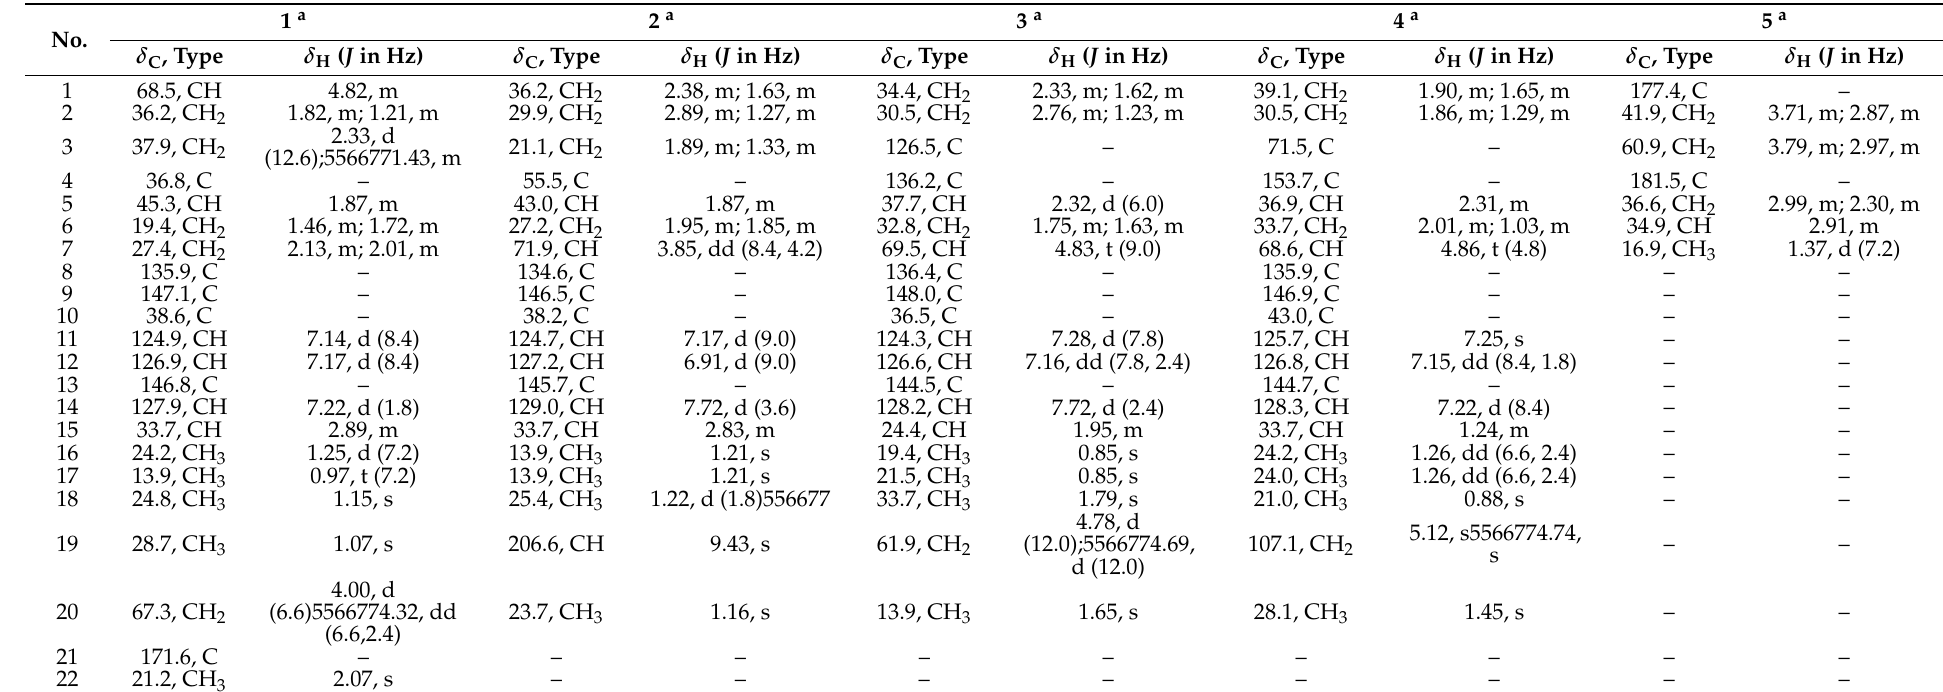
Table 1. NMR spectral data of 1 – 5 (600 MHz for 1 H-NMR and 150 MHz for 13